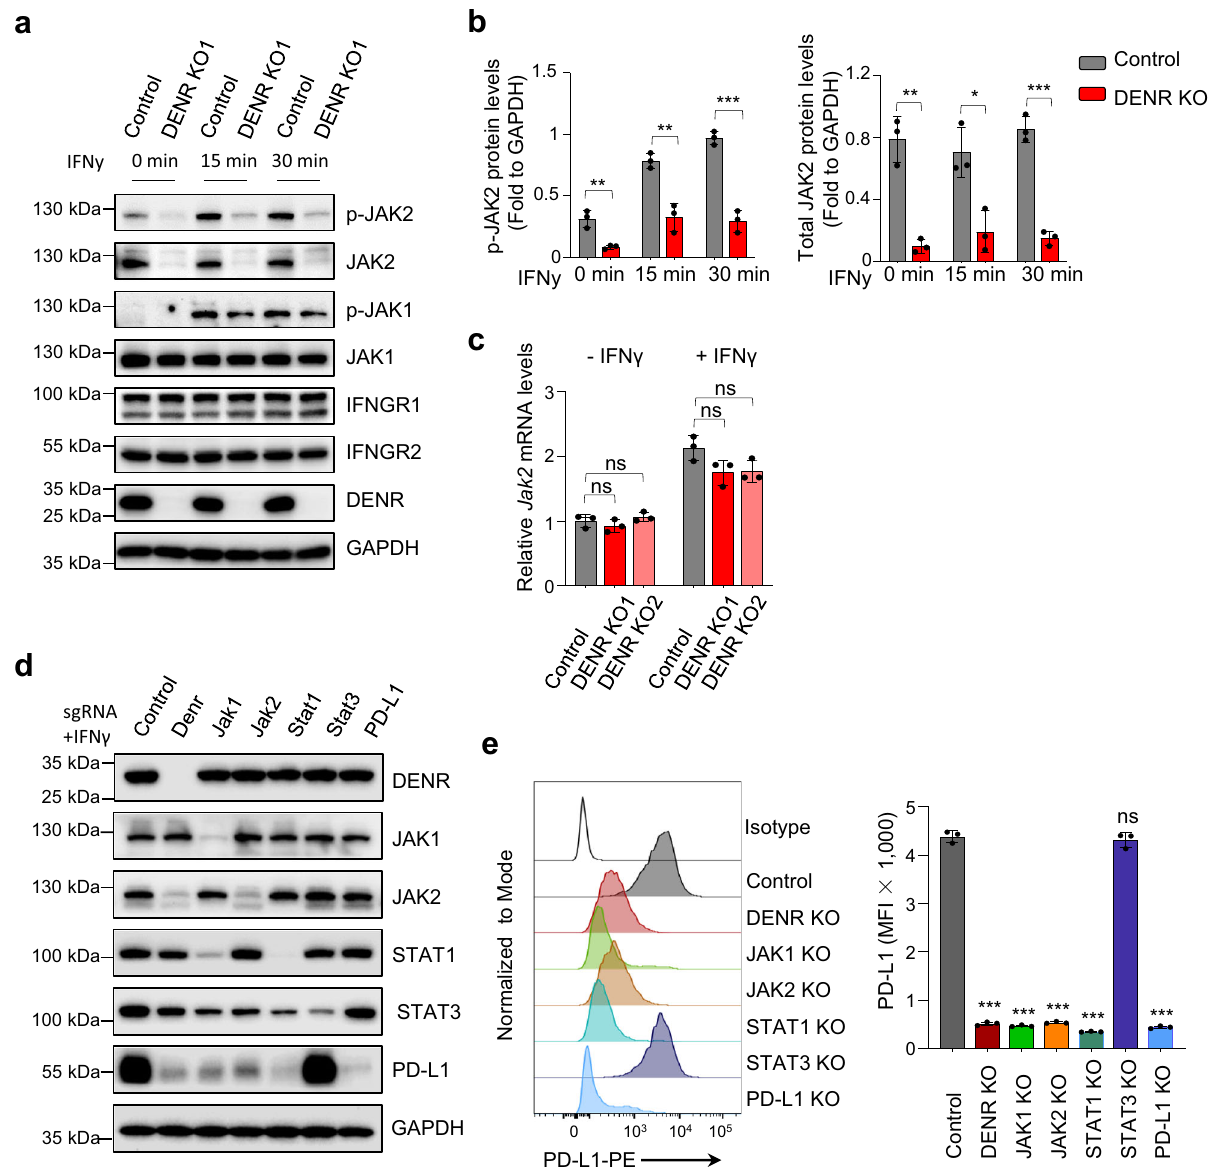
Fig. 3 JAK2 is translationally controlled by DENR. a Western blotting analysis of JAK1/p-JAK1, JAK2/p-JAK2, IFNGR1, and IFNGR2 in control or DENR KO MC38 cells, the experiment was repeated independently three times with similar results. b p-JAK2 and JAK2 were quanti fi ed by normalizing to GAPDH by ImageJ ( n = 3 biologically independent samples). Data are presented as mean values ± SD, unpaired two-tailed Student ’ s t-test: * p < 0.05, ** p < 0.01, *** p < 0.001. p values from left to right: 0.0053, 0.0035, 0.0004, 0.0016, 0.0136, and 0.0002. c RT-qPCR analysis of Jak2 mRNA levels in control and DENR KO MC38 cells, ± IFN γ (20 ng/ml) for 4 h ( n = 3 biologically independent samples). Data are presented as mean values ± SD. Two-sided, one-way ANOVA with Dunnett ’ s post hoc test: ns: not signi fi cant. P values from left to right: 0.5347, 0.6111, 0.0824, and 0.0971. d Western blotting validation of DENR, JAK1/2, STAT1/3, and PD-L1 knockout with speci fi c sgRNAs in MC38 cells, + IFN γ (20 ng/ml) for 24 h. The experiment was repeated independently three times with similar results. e Surface PD-L1 levels were analyzed by FACS in different KO cell lines as indicated, + IFN γ (20 ng/ml) for 24 h ( n = 3 independent samples). Results are representative of three biological replicates. Three technical replicates are shown. Data are presented as mean values ± SD. Two-sided, one-way ANOVA with Dunnett ’ s post hoc test: *** p < 0.001, ns: not signi fi cant. P values from left to right: < 0.0001, < 0.0001, < 0.0001, < 0.0001, 0.7065, < 0.0001. Source data are provided as a Source Data fi le. culture dishes by Cell Counting Kit 8 (CCK8) assay (Supple- 8) and at the late tumor regression time point (day 12) for mentary 5a, b). Then, EGFP-DENR KO and tdTomato-Control sacri fi ce to analyze the ratio of DNER KO to control tumor cells WT MC38 cells were evenly mixed and subcutaneously implanted (Fig. 6a). Interestingly, we found that the percentage of DENR into the fl anks of WT C57BL/6 mice, so that the KO and WT KO tumor cells in all tumors was similar to that of control WT tumor cells grew in the same tumor immune microenvironment, tumor cells on day 8 but much lower than that of WT tumor cells eliminating the extrinsic effects. We monitored the tumor volume on day 12 (Fig. 6b), indicative of a speci fi c and faster clearance of daily, and selected mice at the early tumor growth time point (day DENR KO tumor cells in the same tumor microenvironment. NATURE COMMUNICATIONS| (2022) 13:2059